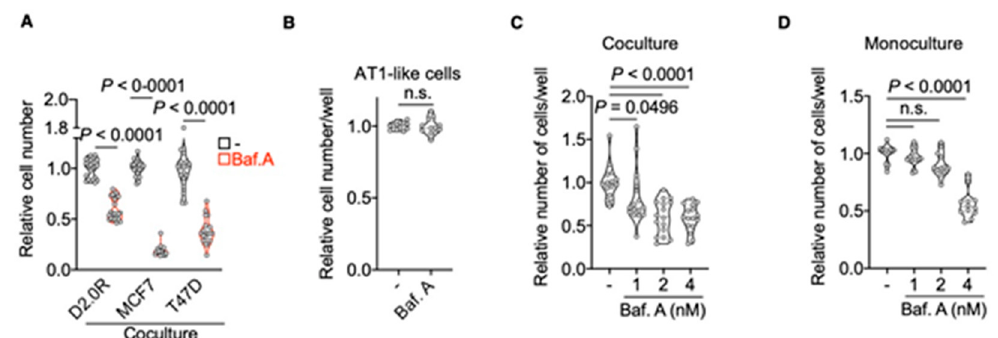
Figure 3. DDCCs are sensitive to inhibition of lysosomal function. ( A ) Relative cell number of the indicated indolent breast cancer cells upon coculture with AT1-like cells, after treatment with 4 nM Bafilomycin A1 for 4 days. n = 4 for D2.0R, n = 3 for MCF7 and T47D-DBM cells (independent experiments). Dunn’s test. ( B ) Mean normalized cell viability, assayed by resazurin staining, of AT1-like cells treated or not with 4 nM Bafilomycin A1 for 4 days. n = 3 independent experiments. Two-tailed t -test with Welch correction. ( C ) Relative number of D2.0R cells in coculture, after 4 days of treatment with different doses of Bafilomycin A1 or control treatment. n = 3 independent experiments. Kruskal–Wallis test. ( D ) Relative number of D2.0R viable cells in monoculture after 4 days of treatment with different doses of Bafilomycin A1 or control treatment. n = 3 independent experiments. Kruskal–Wallis